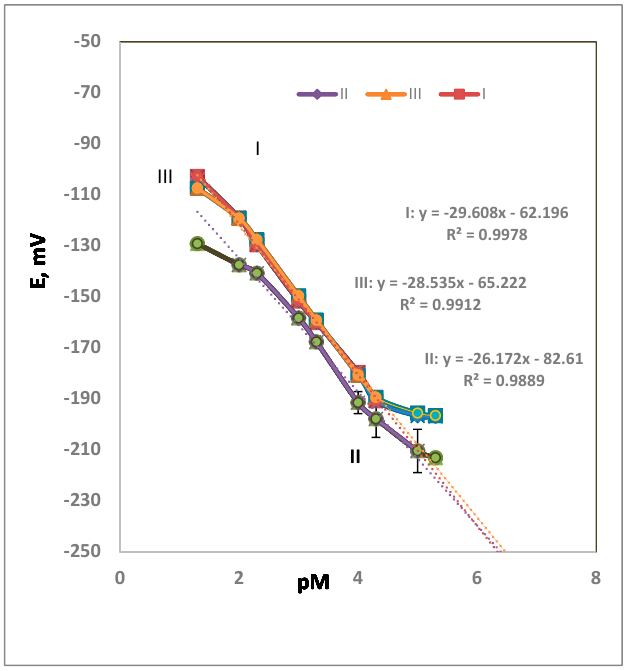
Figure 2. Calibration graph for electrode types I–III (average of four measurements).